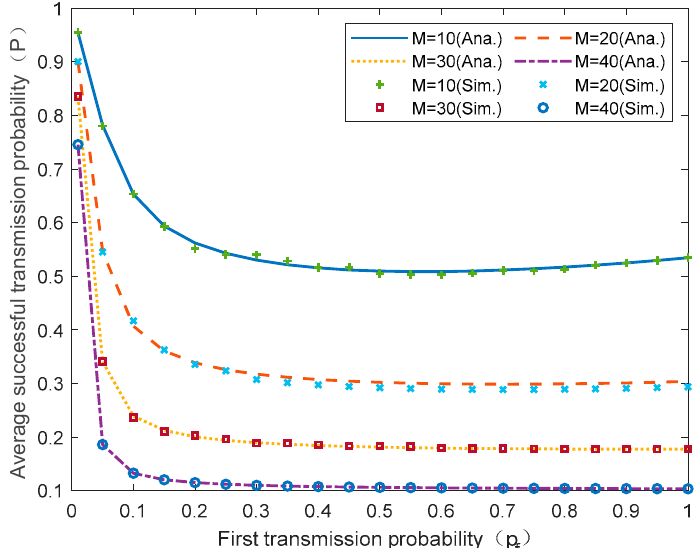
Figure 11. Successful transmission probability vs. first transmission probability (Ana. vs. Sim.).